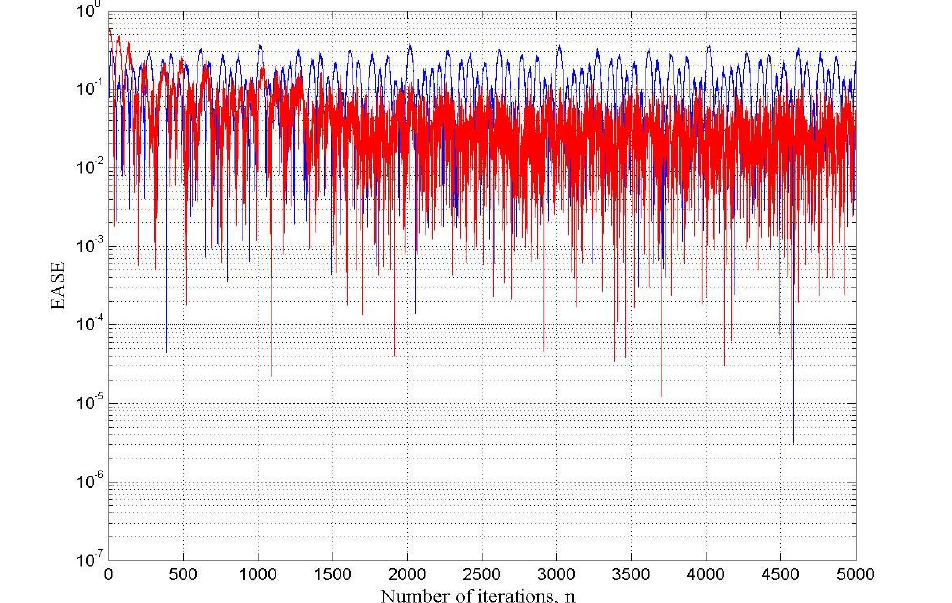
Figure 11. Learning curve of the conventional (blue) and the fast (red) LMS adaptive filters for the case under test: EASE is the ensemble-average squared error (logarithmic